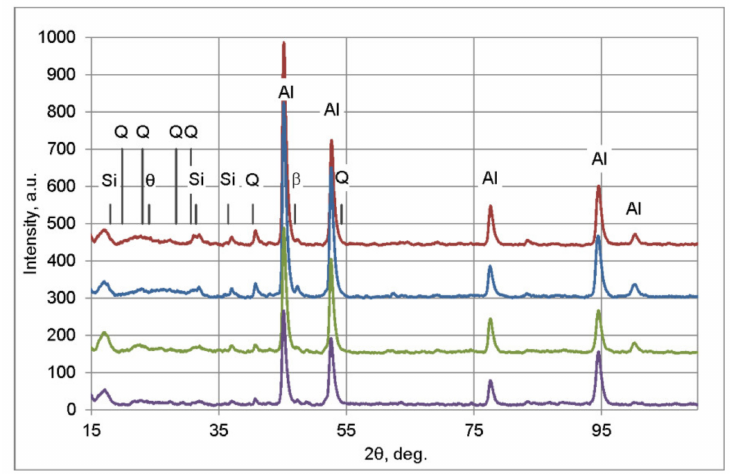
Figure 9. Results of X-ray diffraction phase analysis in as-cast state and after each soaking stage (followed by water quenching). The following JCPDS card was used for peaks identification: 00-004- 0787, 00-034-0458, 01-075-0841, 00-041-1068,